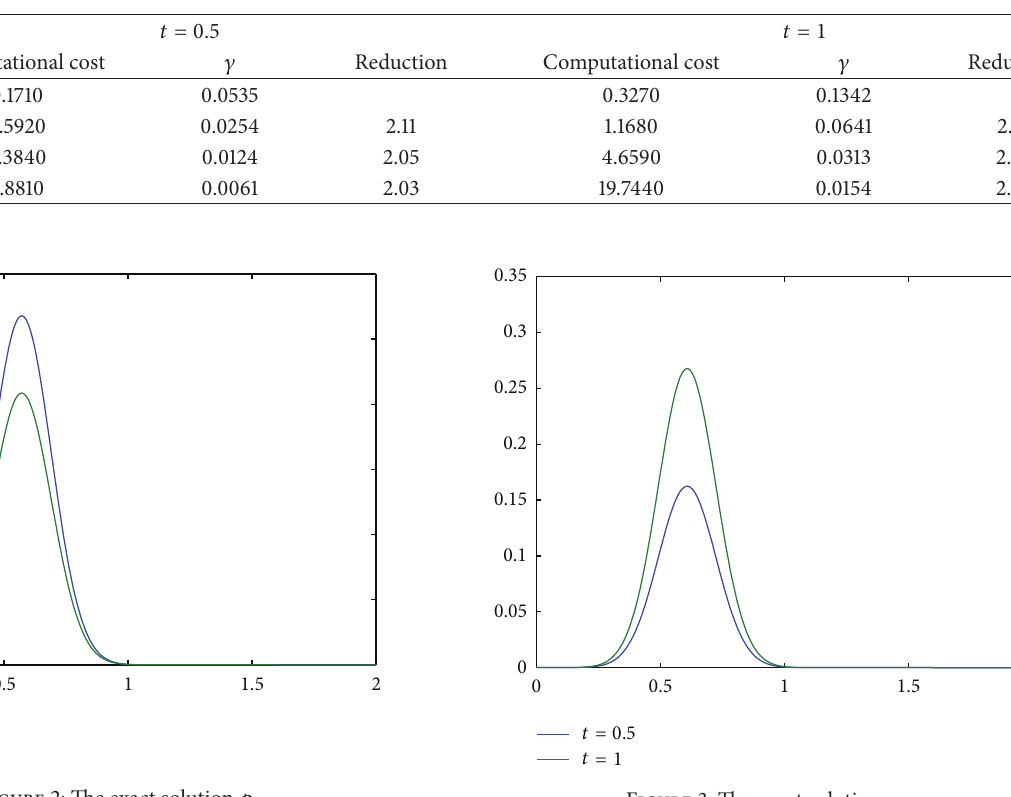
Table 2: Error estimate in maximum norm when 𝐷(𝑥) = 𝑥 .